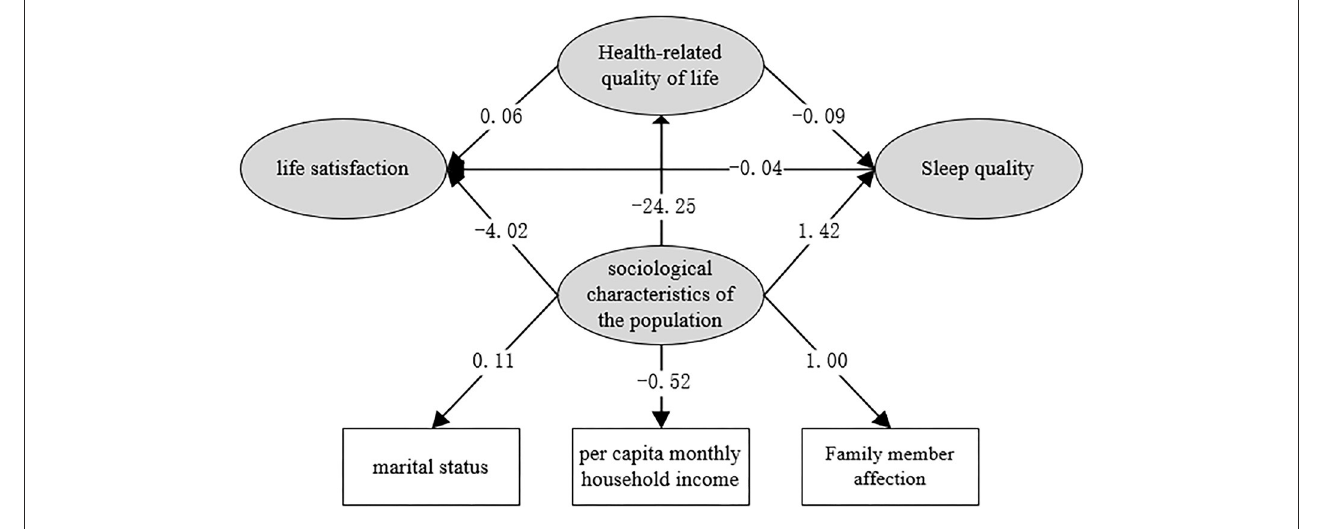
FIGURE2 Structural equation model path coefficients